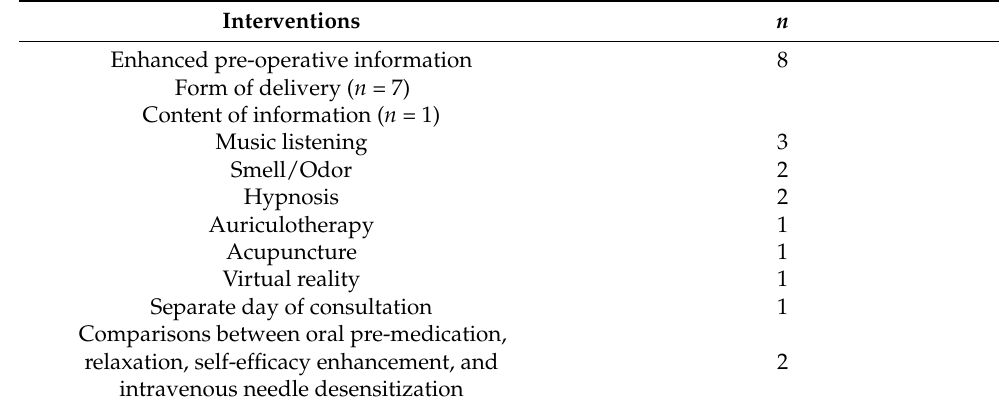
Table 1. Category of non-pharmacological interventions of included studies in a systematic review. Interventions n Enhanced pre-operative information 8 Form of delivery ( n = 7)